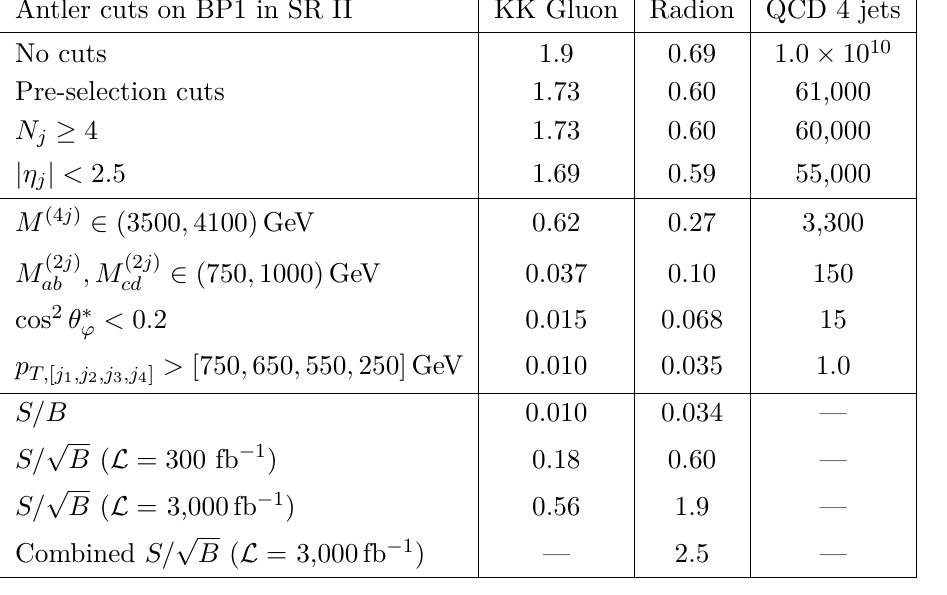
— = 3 . 5 , (cid:15) = 1 , m ( G ) = 4 TeV , m ( g ) = KK KK KK